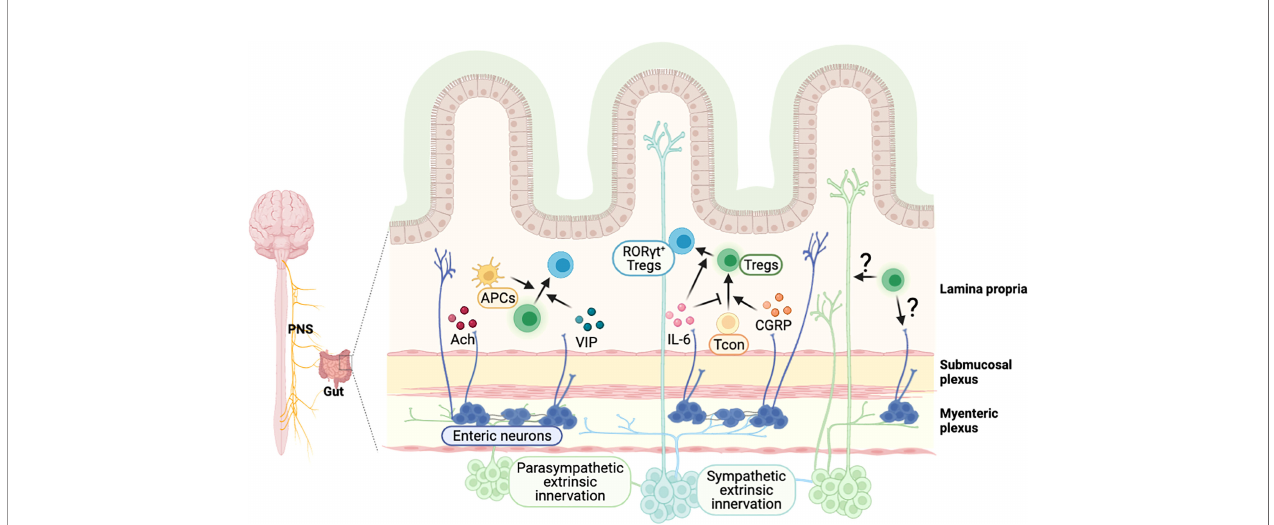
FIGURE 4 | Possible model of crosstalk between intestinal Tregs and gut-innervating neurons. External neuronal cells from the peripheral nervous system innervate to the intestine, and neurons in the enteric nervous system exist in the colonic myenteric and submucosal plexus. Neuronal factors, released from the nerve terminal, are involved in the regulation of intestinal Tregs. A neurotransmitter acetylcholine (Ach) activates colonic antigen presenting cells, which may support the development of pTregs in the intestine. Vasoactive intestinal peptide (VIP) enhances the proliferation of Tregs and calcitonin gene-related peptide (CGRP) promotes the differentiation of Tregs. Cytokines such as IL-6, produced by neuronal cells, regulate the induction of ROR g t + Tregs. It is expected that Tregs-derived molecules can signal to neuronal cells to modulate their function, which have to be further